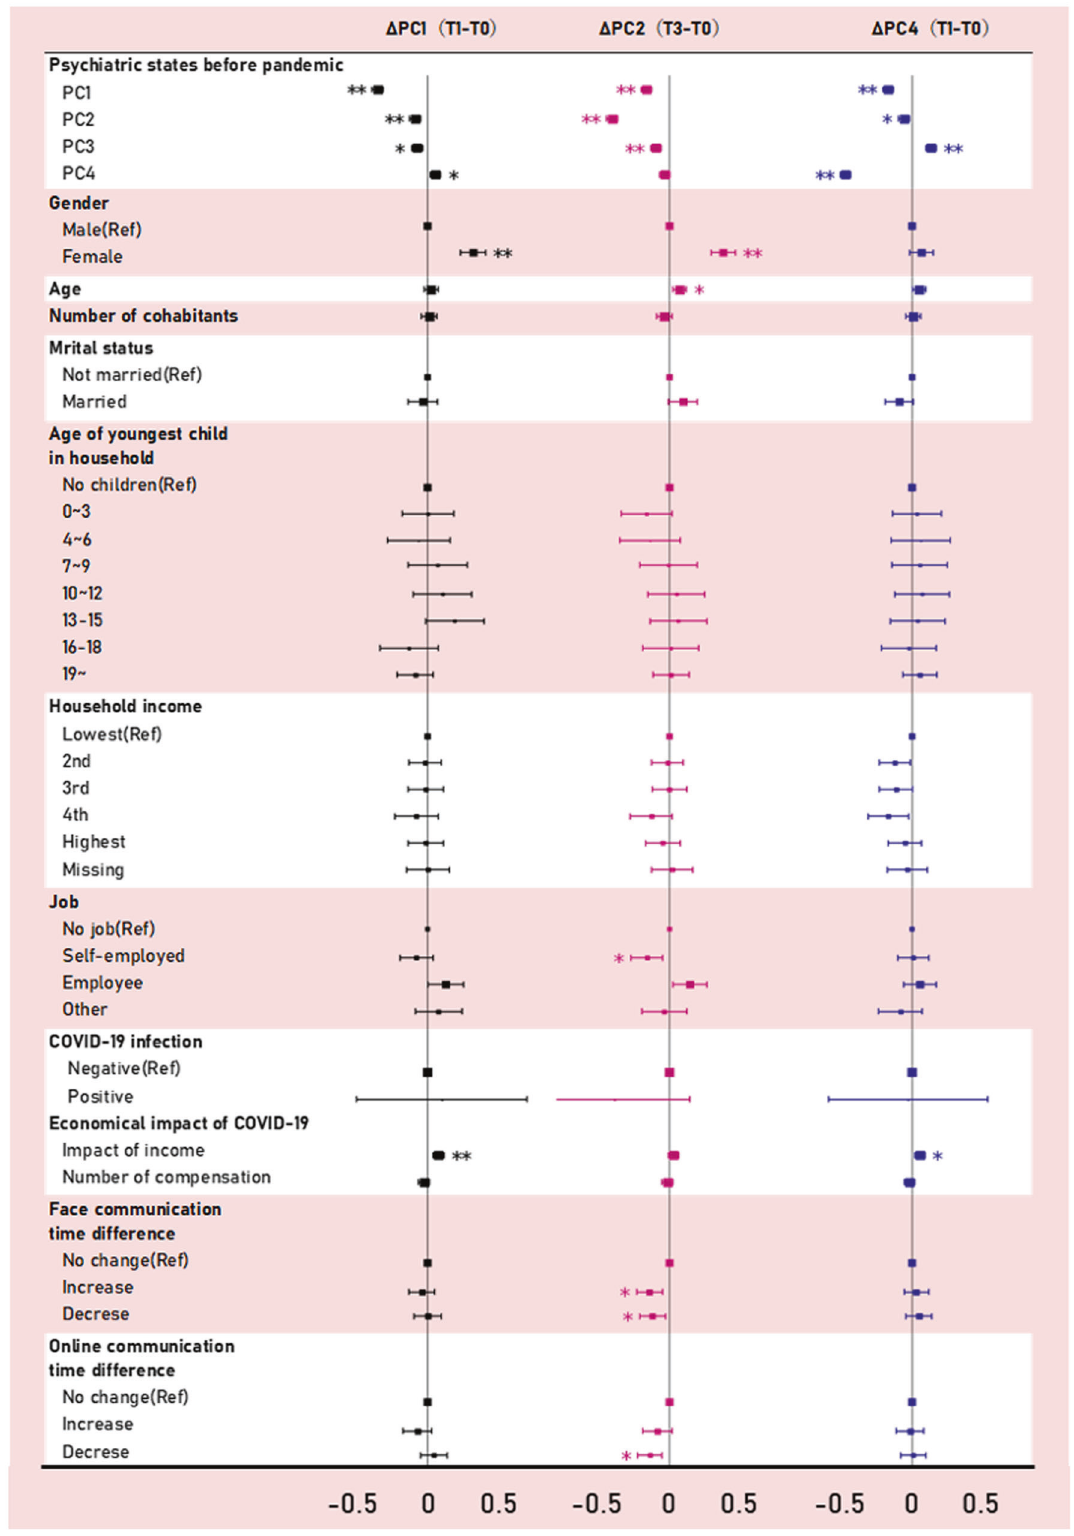
Fig. 4 Fixed-effects regression analyses showing within-person changes in multidimensional psychiatric status during the pandemic. Forest plots show results of fi xed-effects regression analyses. Each plot represents standardized beta coef fi cients with standard errors. Asterisks indicate statistical signi fi cance (* p < 0.05, ** p <